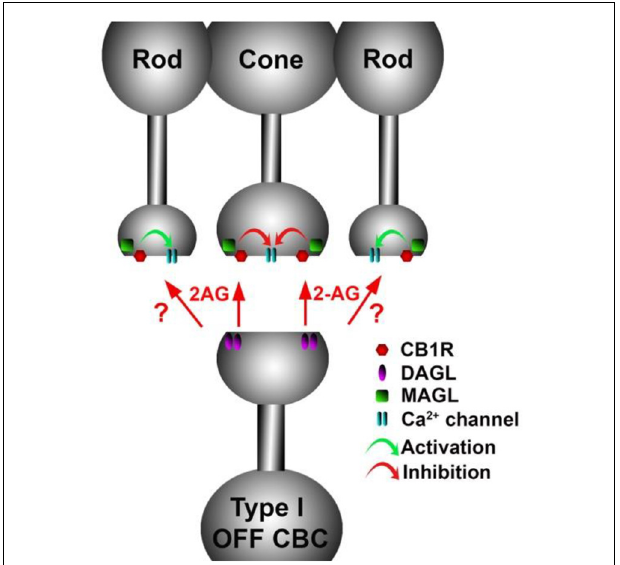
FIGURE 9 | A retrograde cannabinoid CB1 circuit in the OPL. Rod and cone photoreceptors signal to neurons in the inner nuclear layer (INL). Both rods and cones express CB 1 receptors. The 2-AG synthesizing enzyme diacylglycerol lipase (DAGL) is present in the post-synaptic terminal of Type I OFF cone bipolar cells (OFF CBC). 2-AG released by DAGL travels retrogradely, presumably to CB1 receptors on cones, and perhaps also rods. CB 1 receptors, when activated, differentially act on presynaptic calcium channels, activating them in cones and inhibiting them in